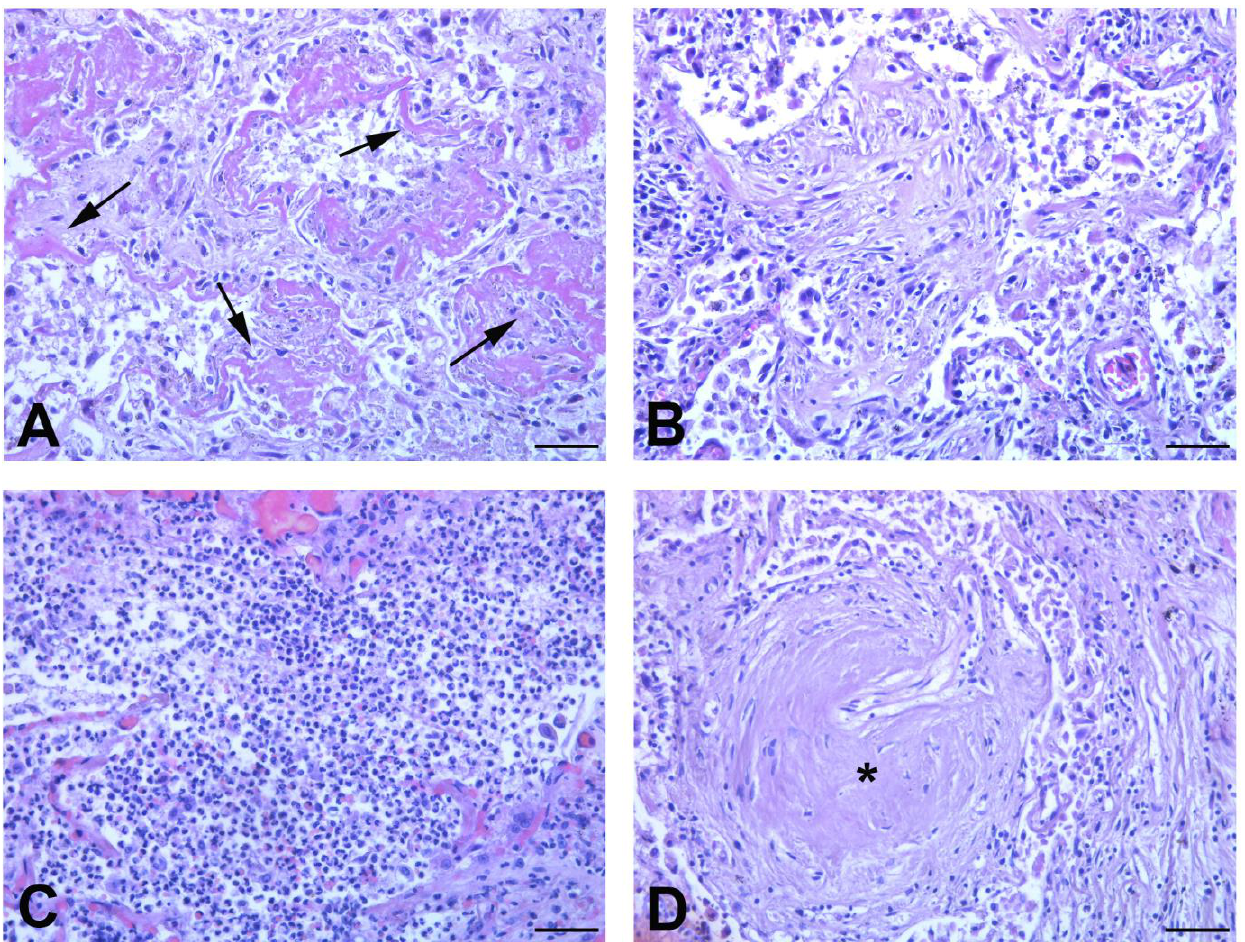
Figure 1. Histopathological features of autoptic lung from unvaccinated and vaccinated COVID-19 pa- tients. ( A , B ) Representative Hematoxylin and Eosin-stained section, from lung tissue of unvaccinated patients. ( A ) Acute exudative pattern of diffuse alveolar damage (DAD), with hyaline membranes deposition (arrows). ( B ) Intra-alveolar plug of organizing connective tissue (proliferative/organizing phase). ( C , D ) Representative histological findings in lung tissue of vaccinated patients: ( C ) massive neutrophils infiltration indicative of bacterial bronchopneumonia; ( D ) arthritis rheumatoid fibrotic nodule (*). Scale bars: ( A – D ) = 28 µ